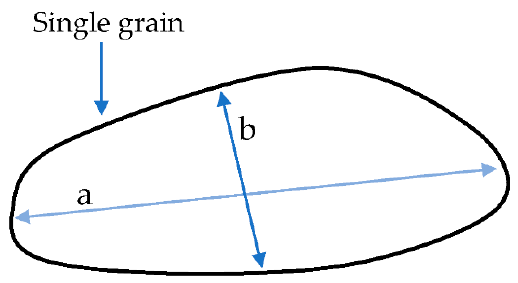
Figure 6. Schematic diagram showing the process of measuring average grain size.